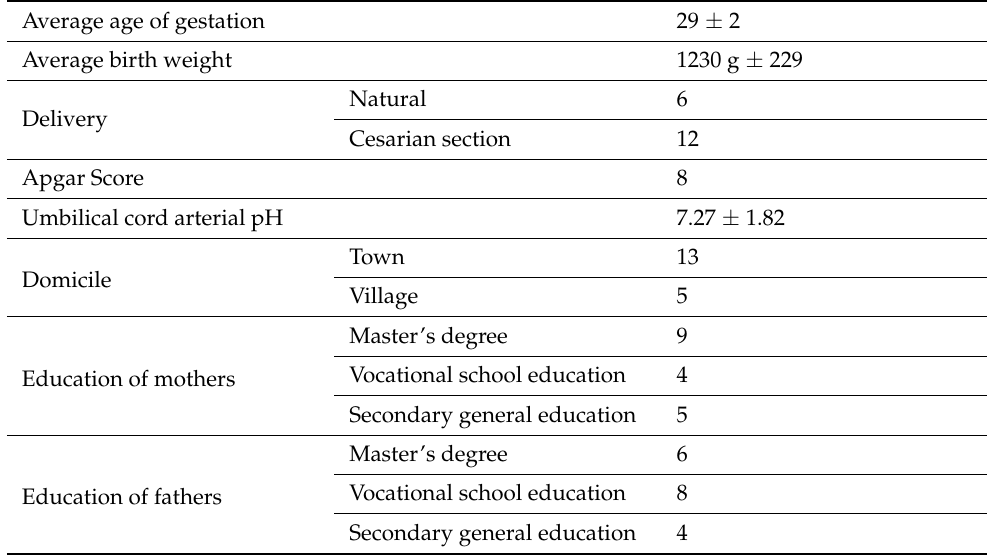
Table 1. Demographic data of the